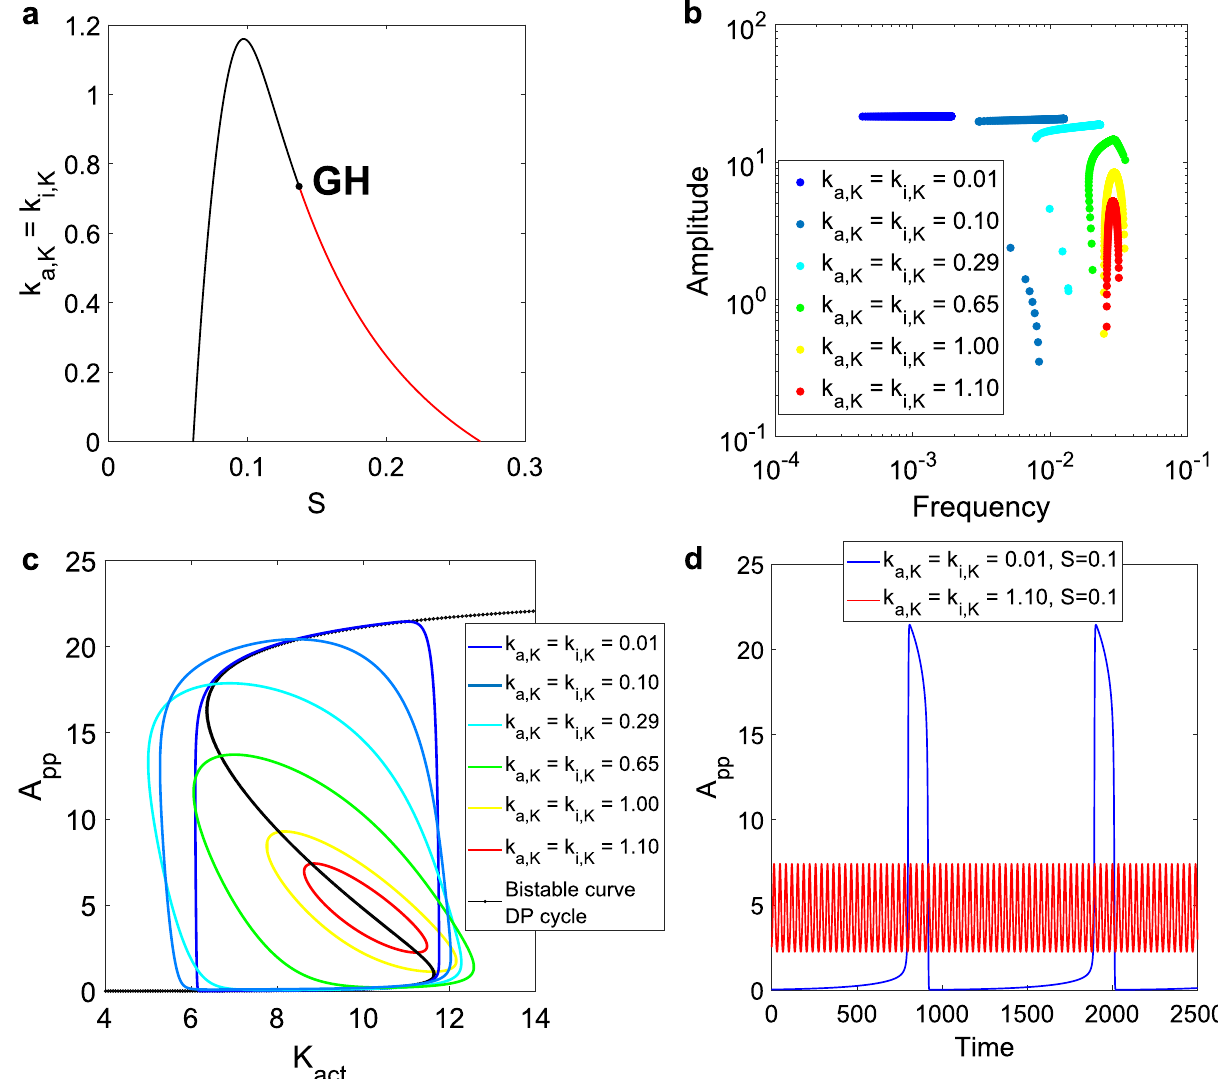
Figure 2. Results for the timescale separation analysis of the SK model. ( a ) 2D bifurcation diagram of k i,K and S, with k i,K = k a,K . In black, the supercritical Hopf curve. In red, the subcritical curve. The Generalized Hopf (GH) bifurcation is included in black. The oscillatory region is bordered by the x-axis and both Hopf curves. The S range where oscillations are found increases with the timescale separation. ( b ) Amplitude vs. frequency curves for six different values of k i,K = k a,K , scanning the input parameter S. As the timescale separation increases, the curves move up and left, going from wide amplitude ranges and small frequency ones to the inverse case. For the lowest values of k i,K , some low amplitude values can be found on the left branch of the curves, where there is a supercritical Hopf, if the parameter is precise enough. ( c ) One limit cycle for each of the six previous cases (with S = 0.1), plotted against the underlying bistable curve of the DP cycle, while scanning the active kinase parameter (K act ). The limit cycles take more advantage of the bistable amplitude as k i,K decreases. ( d ) Time series for the two extreme cases, showing the clear difference in amplitude and